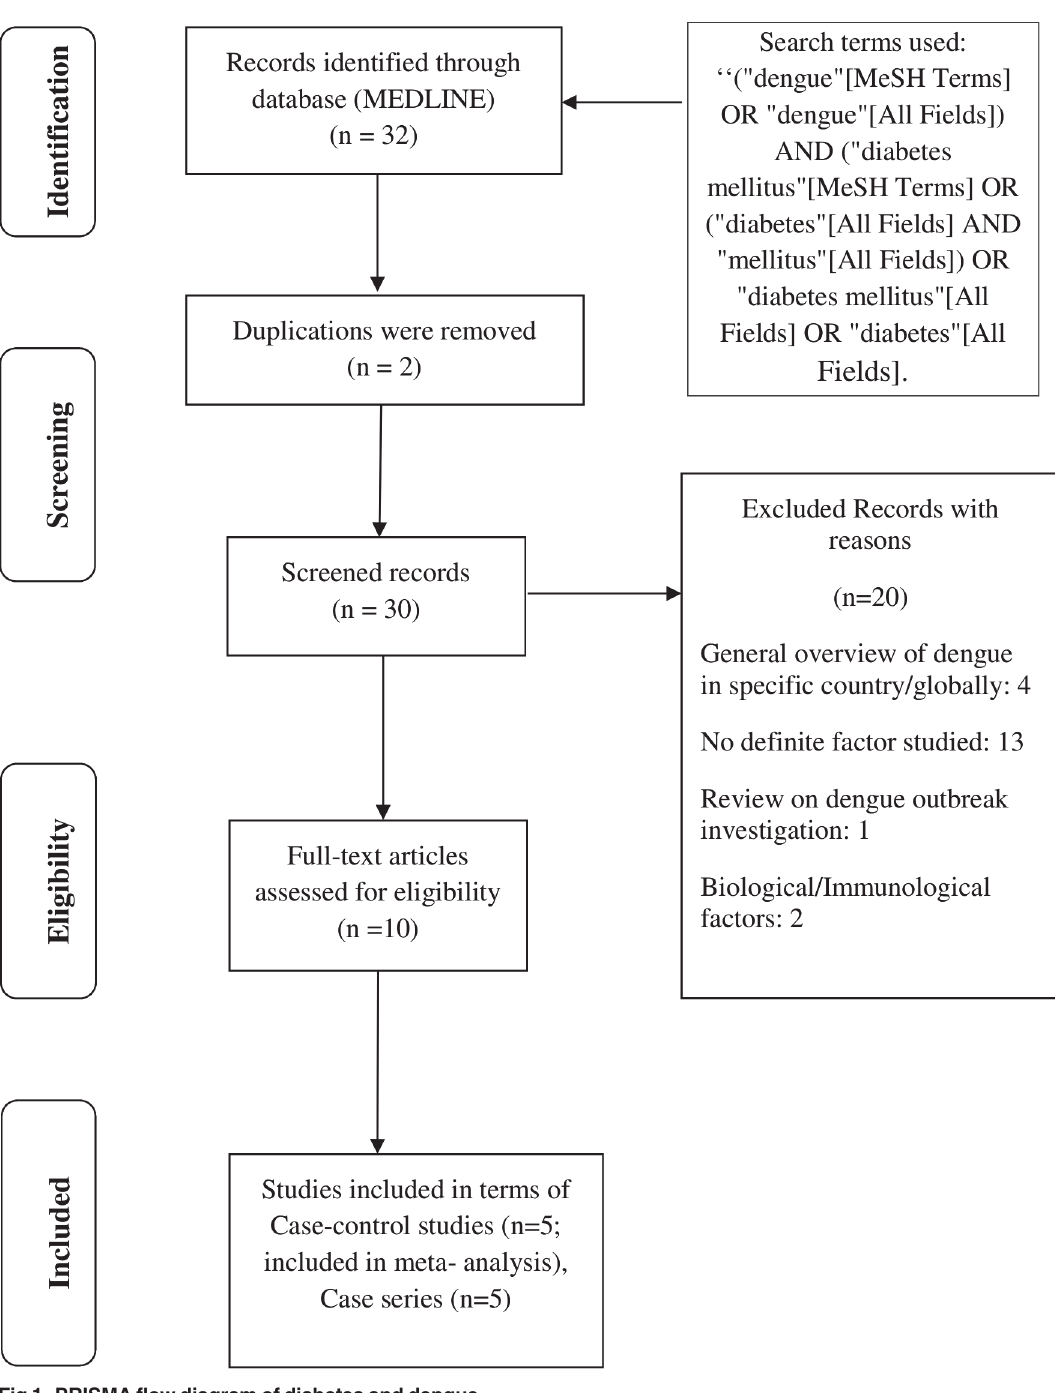
Fig 1. PRISMA flow diagram of diabetes and